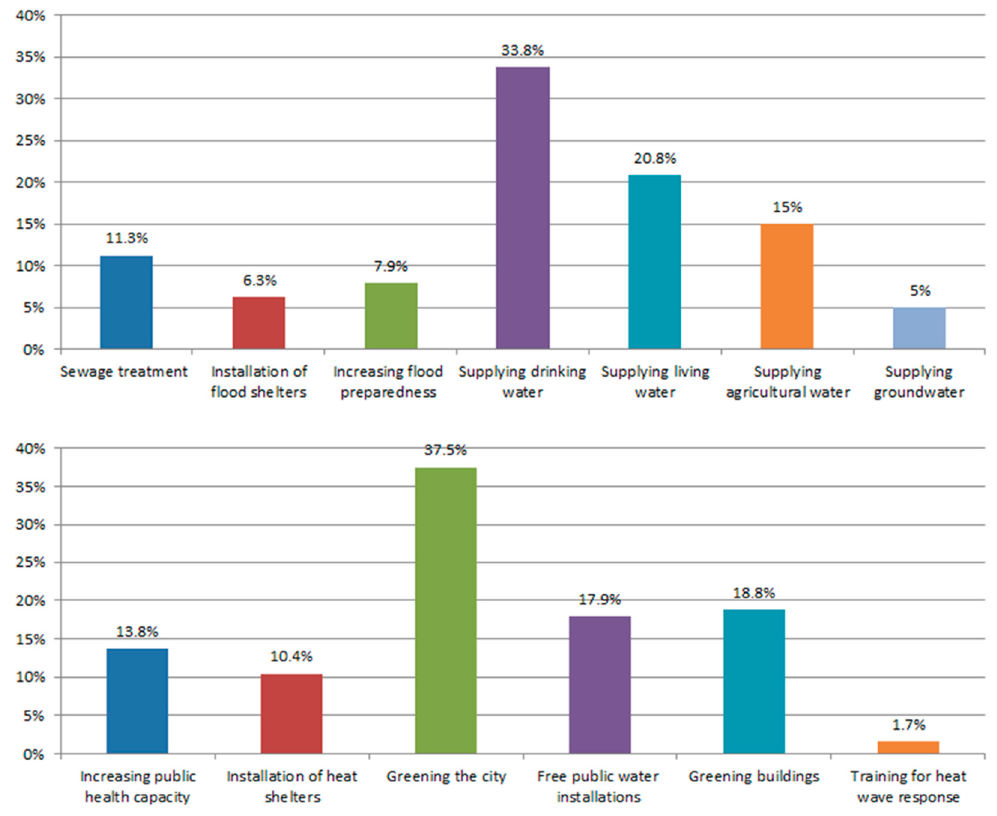
Figure 9. The most desirable climate change measures with respect to the water ( top ) and heat ( bottom ) sectors as assessed by the women respondents.